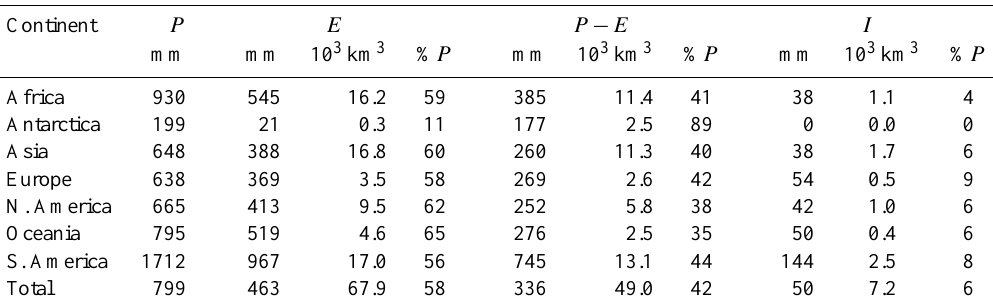
Table 2. Annual precipitation ( P ), evaporation ( E ) and water available for runoff ( P − E ) divided by continents for the period 2003–2007. The contribution of rainfall interception loss ( I ) to E is also presented.